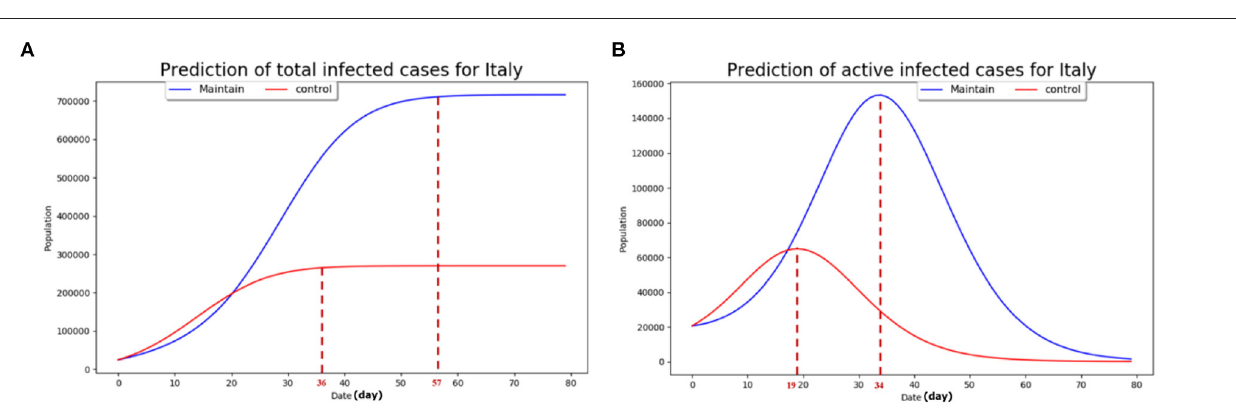
FIGURE 3 | The predictions based on the developed model. (A) The estimate of the total infected cases with the two prevention control strategies; (B) the estimate of the current infected cases with the two prevention control strategies. The maintain scenario refers to the case where the public authority’s mobilization of social resources to tackle the epidemic spread is relatively slow and inefficient with disobedience of the general public. The control scenario refers to the case of strict prevention and control measures adopted by the government at the initial phase of the COVID-19 outbreak with good obedience by the general public with regards to mandatory regulation such as